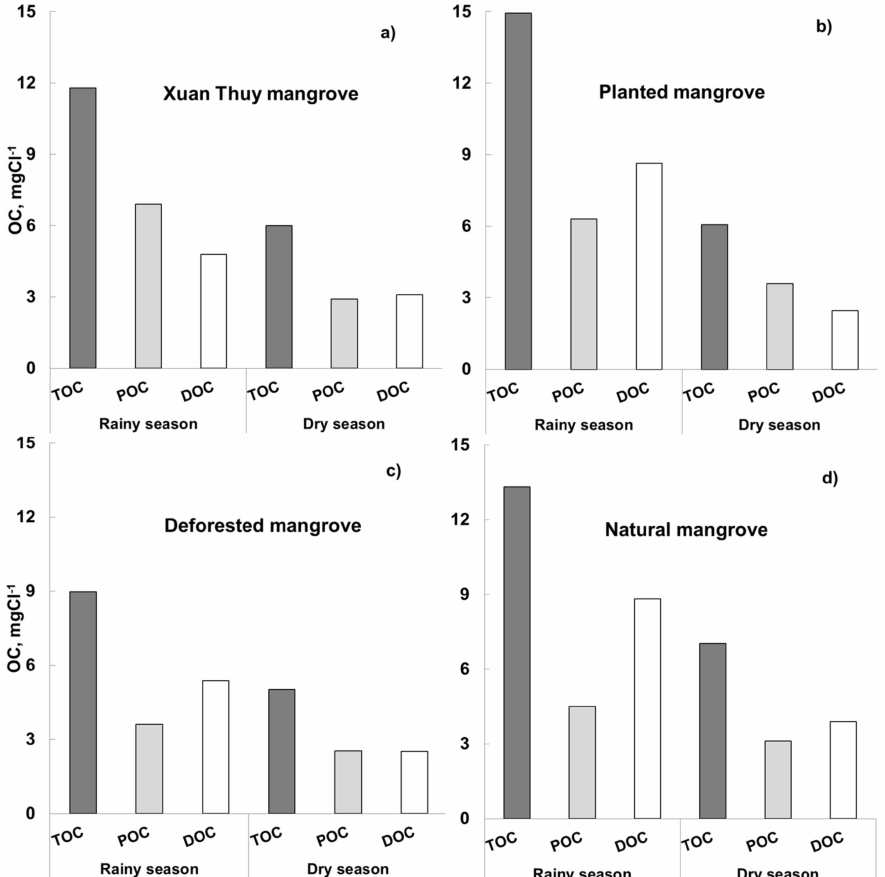
Figure 2. Spatial variation of OC in different locations: ( a ) the entire Xuan Thuy mangroves; ( b ) Planted mangroves; ( c ) Deforested mangroves; ( d ) Natural mangroves. Mean POC concentrations have significant seasonal variations (rainy season: 6.9 ± 1.6 mgCL − 1 ; dry season: 2.9 ± 0.4 mgCL − 1 , Figure 2a). This pattern was